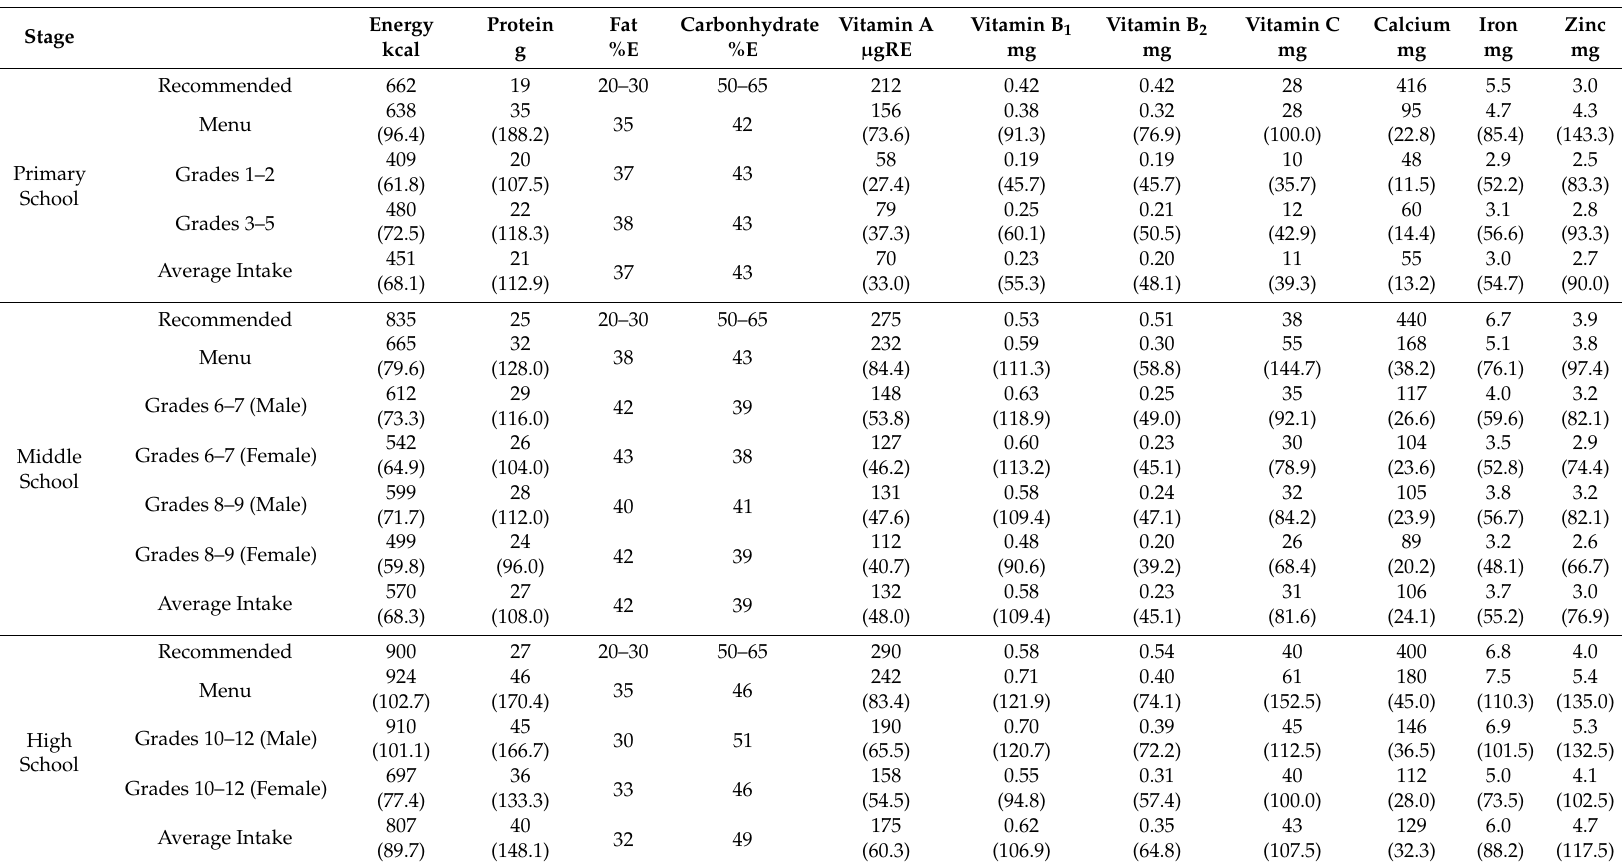
Table 4. Actual intake and proportion to the recommended amounts of energy and nutrients in seven schools among different age groups and sexes/ n